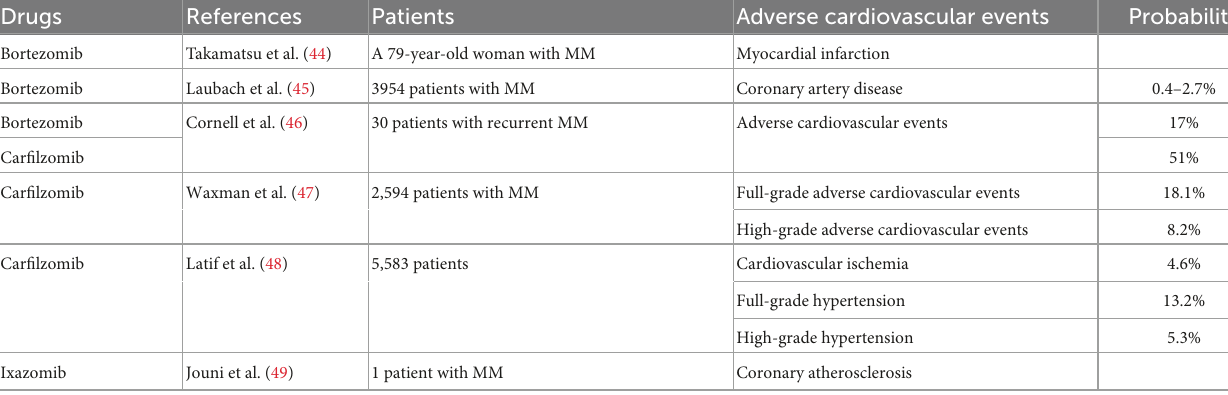
TABLE 4 Summary of clinical studies on cardiotoxicity of proteasome inhibitors. Drugs